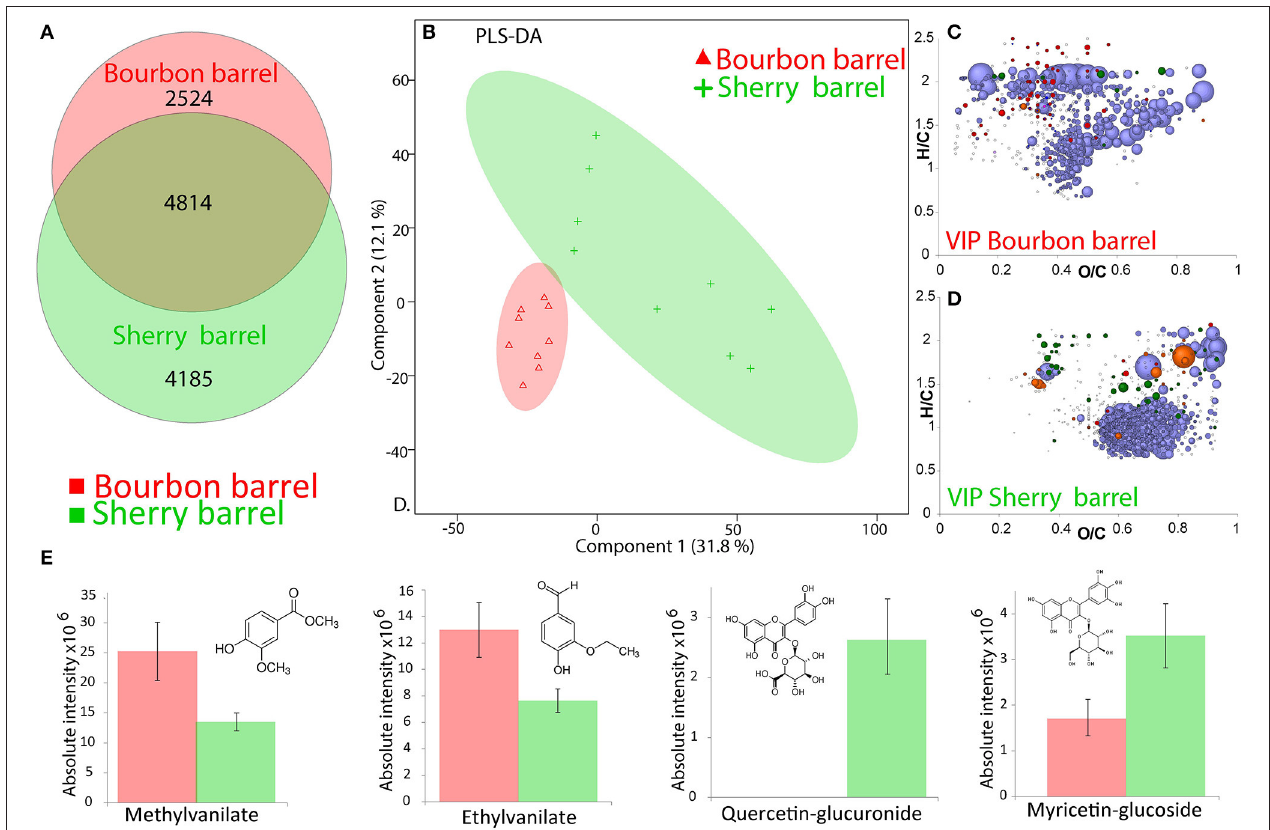
FIGURE 3 | Visualization of the FT-ICR-MS data from Whiskies matured in Bourbon barrels (BB) and Sherry barrels (BB). (A) Common and unique features from SB and BB Whiskies, represented in a Venn diagram. (B) PLS-DA score plot for a model based on nine BB samples and nine SB samples (R2Y = 0.7 and Q2 = 0.4), the ellipses are showing the confidence intervals at 95%, the two first components explained 43.9% of the total variability. Van Krevelen diagrams for the “VIP” features extracted from the PLS-DA for whisky matured in (C) BB and (D) SB. (E) Bar chart of the absolute intensity of some wood biomarkers significantly more present either in BB Whiskies (red) or in SB Whiskies (green) with a p < 0.05. Points in van Krevelen diagrams are colored according to their elemental composition, CHO in blue, CHOS in green, CHON in orange, and CHONS in red, scaling according to their relative peak intensity.